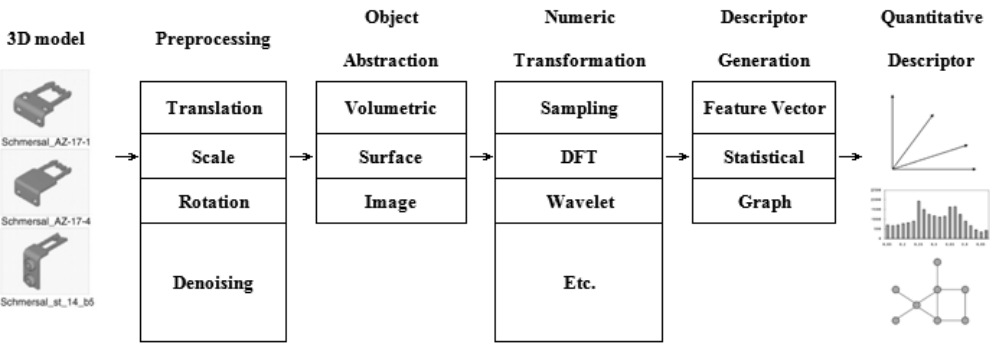
Figure 1. The common 3D model retrieval process.